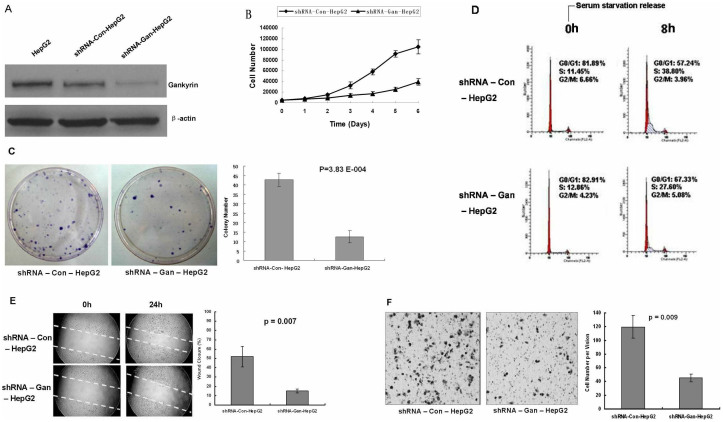
Inhibition of the malignant phenotypes of HepG2 cells by silencing Gankyrin expression in vitro.The results are presented as the mean of three independent experiments, with the corresponding standard deviation (B, C, D, E, and F). (A) Western blot analysis of Gankyrin protein expression in shRNA-Con-HepG2 and shRNA-Gan-HepG2 cells. β-actin was used as an internal control. Gankyrin protein expression was significantly lower in shRNA-Gan-HepG2 cells than in shRNA-Con-HepG2 cells. (B) Growth curves for shRNA-Con-HepG2 and shRNA-Gan-HepG2 cells. shRNA-Gan-HepG2 cells were significantly fewer than shRNA-Con-HepG2 cells (second day: 15533.3 ± 1137.25 vs. 9500.0 ± 1212.44, P = 0.003; third day: 32733.3 ± 6404.95 vs. 13933.3 ± 2936.55, P = 0.010; forth day: 58033.3 ± 5204.17 vs. 17466.7 ± 3350.12, P = 3.43 E-04; fifth day: 91500.0 ± 6378.87 vs. 25100.0 ± 4190.47, P = 1.13 E-04; sixth day: 104833.3 ± 13089.05 vs. 39300.0 ± 5692.98, P = 0.001). (C) The tumorigenicity of shRNA-Gan-HepG2 cells was significantly lower than that of controls, as evaluated using the soft agar colony formation assay. (D) A cell cycle assay performed by flow cytometry. Downregulation of Gankyrin expression in HepG2 cells led to the prohibition of cell cycle progression from G1 to S phase. (E) Representative images of wound healing assays showing that the migratory capability of shRNA-Gan-HepG2 cells was significantly suppressed compared to controls. (F) The invasion potential was analyzed by a Matrigel invasion assay. The invasion of shRNA-Gan-HepG2 cells was statistically decreased compared to controls.